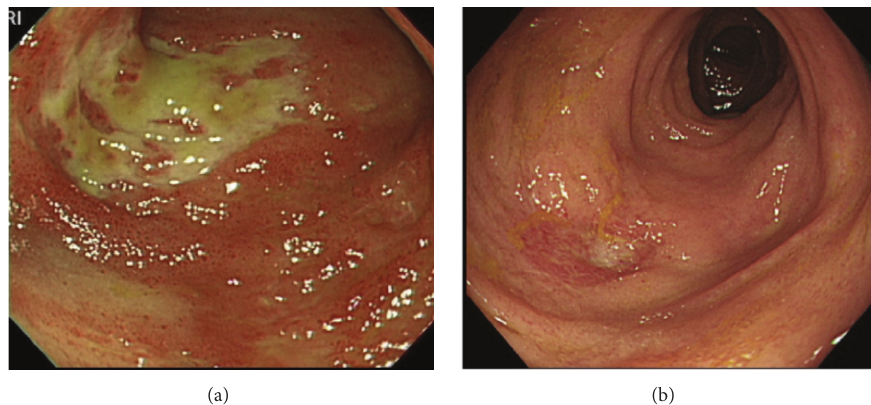
Figure 3: Lower gastrointestinal endoscopic observations. (a) On admission, lower gastrointestinal endoscopy revealed ulcers in the terminal ileum. (b) A week after the initiation of adalimumab, lower gastroendoscopy showed epithelialization of the ulcers.